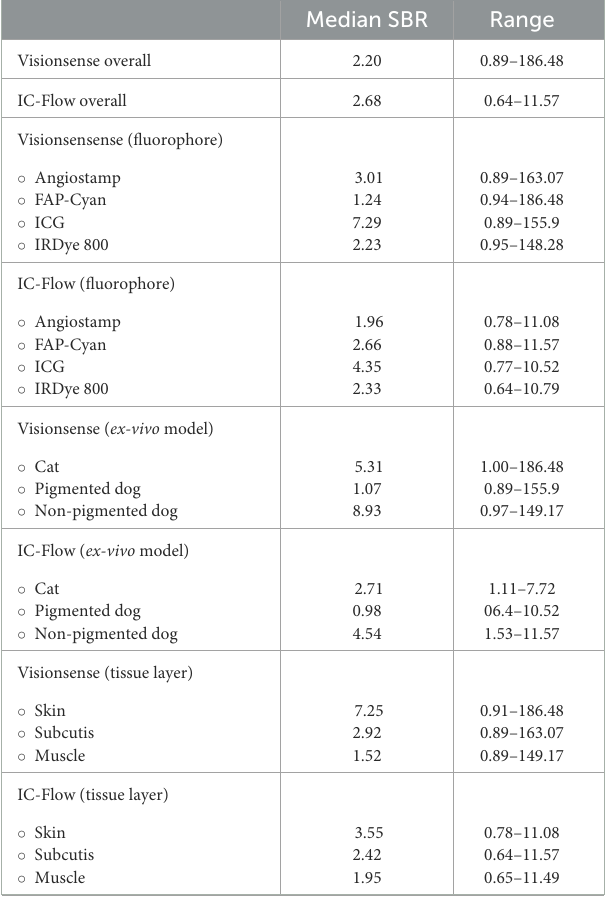
TABLE 2 Estimated median SBR (signal-to-background ratio) values for Visionsense TM VS3 iridium and IC-Flow TM